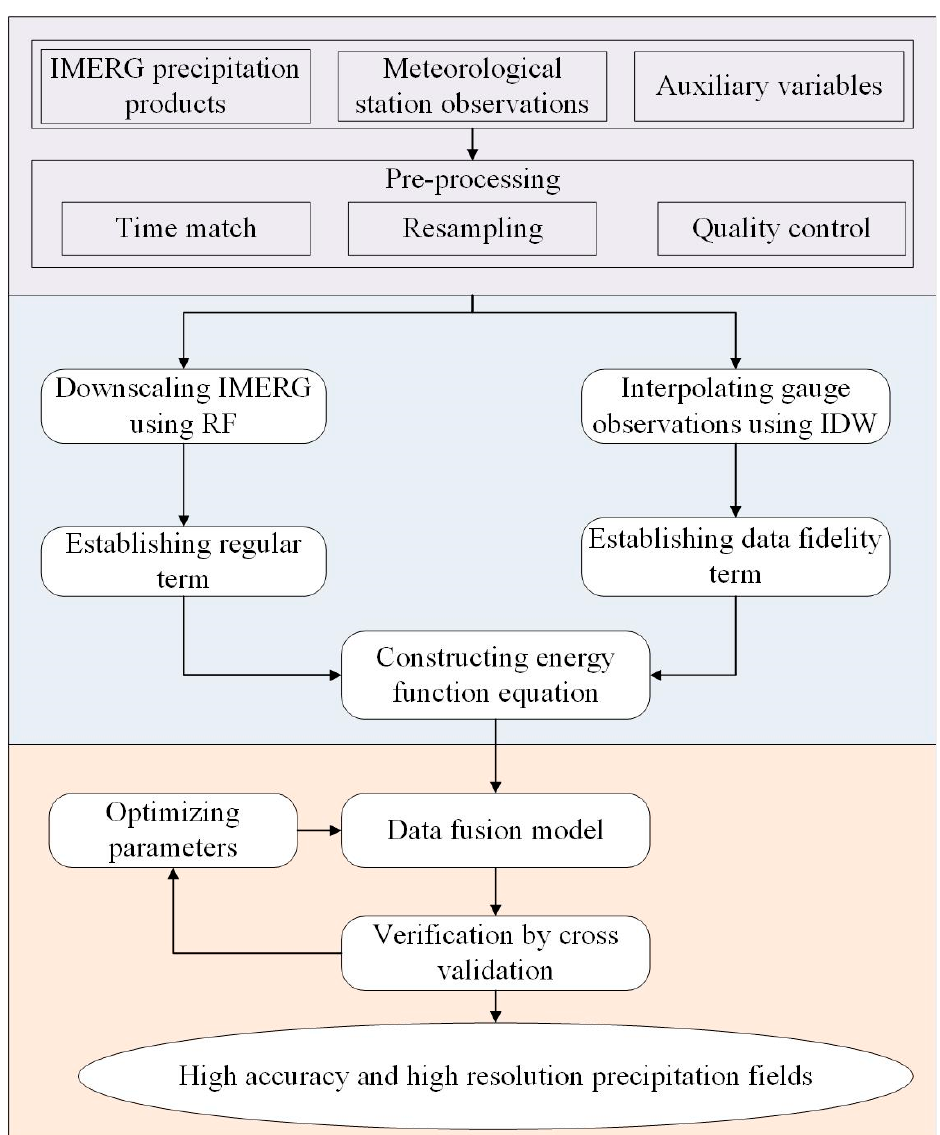
Figure 2. Flow chart of the proposed precipitation fusion method.